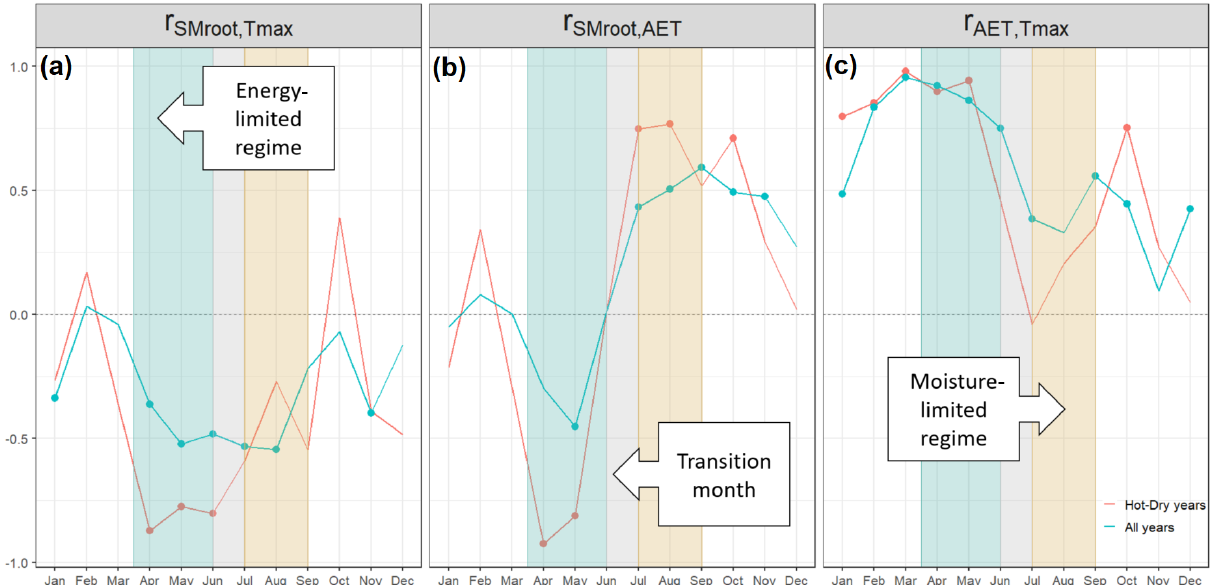
Figure 7. Interannual correlation between various pairs of temperature and moisture variables for a given month of the year, repeated over the various calendar months, conditioned on hot–dry events. Dots indicate statistical significance at the 95% confidence. Shaded regions represent important differences in the coupling that can play a critical role in the development of hot–dry